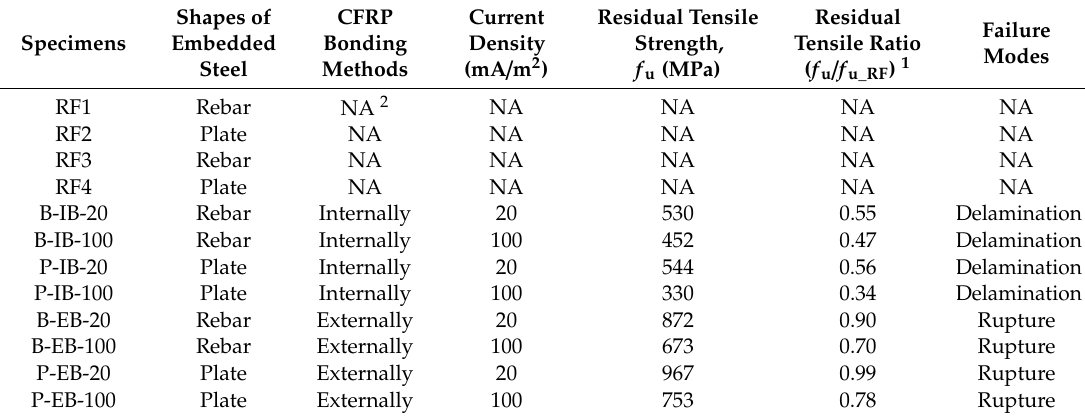
Table 3. Test specimen parameters and tensile test results.